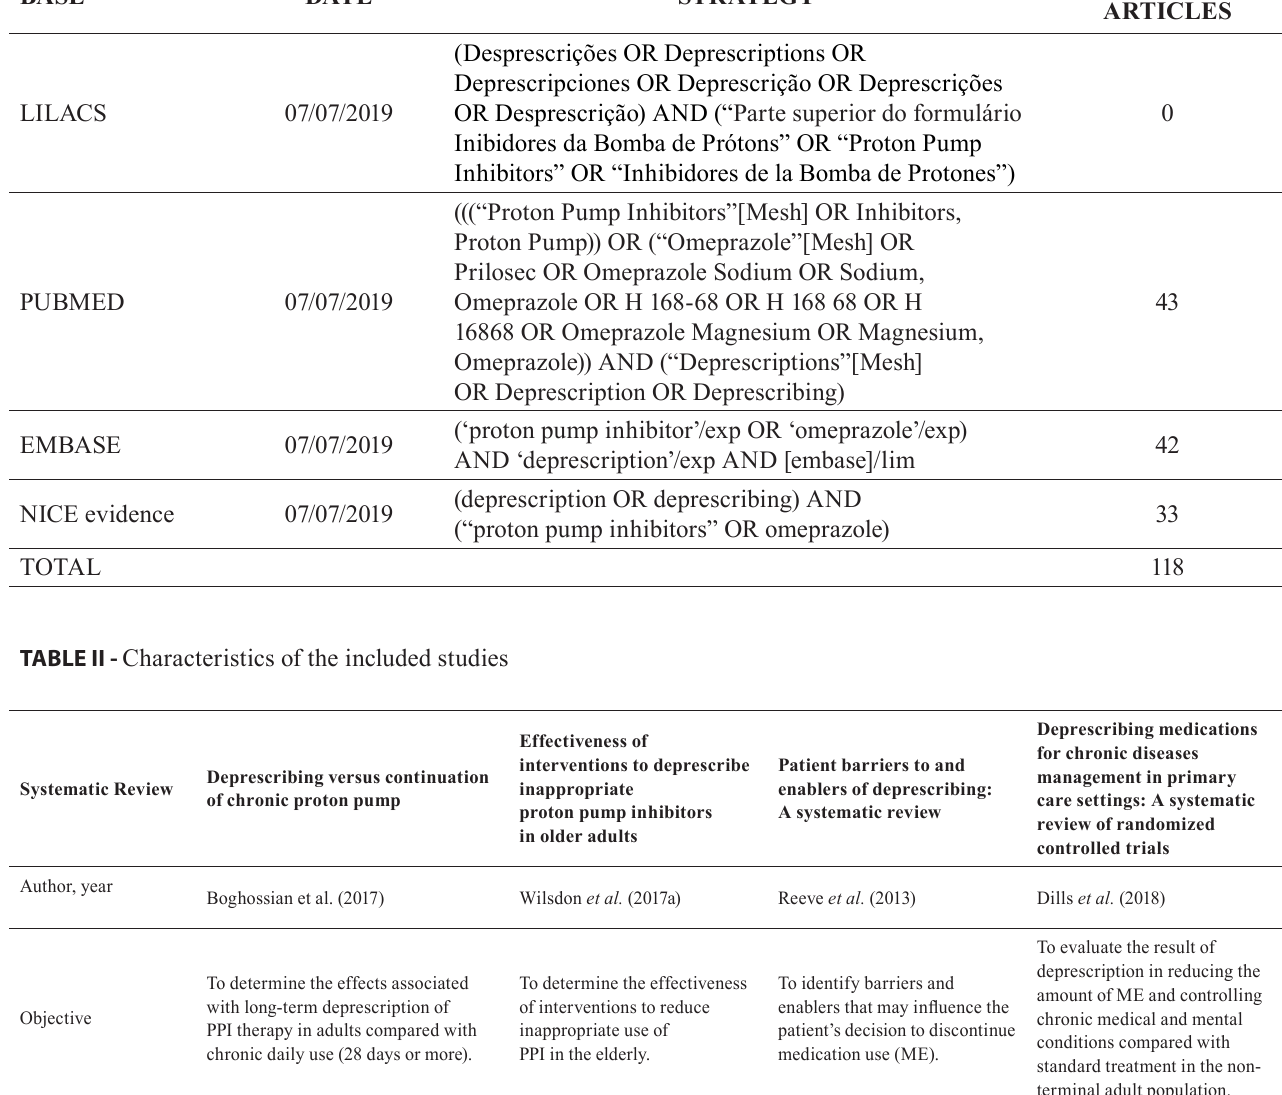
TABLE I - S earch strategies in scientific literature databases BASE